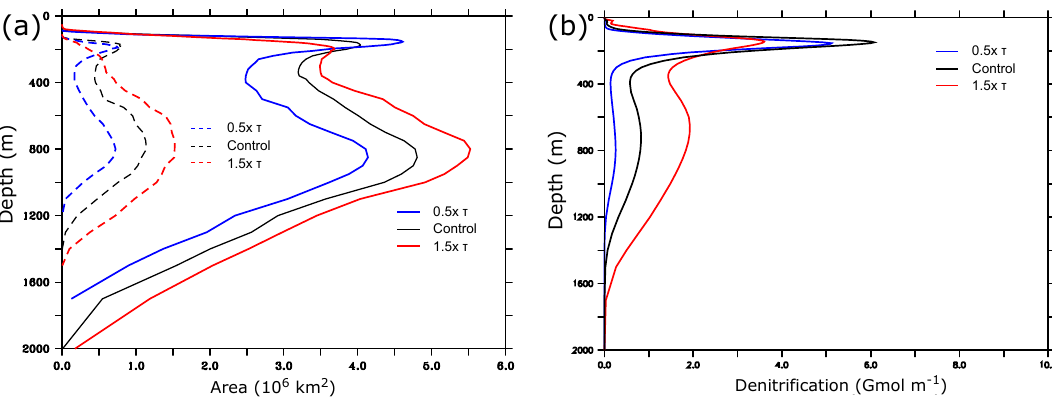
Figure 7. Changes in the Arabian Sea OMZ and denitrification as a function of depth. (a) Total area (in 10 6 km 2 ) occupied by hypoxic (solid lines) and suboxic (dashed lines) waters as a function of depth under different monsoon wind intensities. (b) Arabian Sea integrated annual-mean denitrification (in 10 9 molm − 1 ) as a function of depth. Note the presence of a weak secondary maximum in domain-integrated denitrification between 500 and 800m in all simulations. In the control simulation, this can be explained by the fact that at this depth range the area occupied by (potentially denitrifying) suboxic water is largest, and weak denitrification is still present although at an order of magnitude weaker rate (per unit of volume basis) than at 200m.